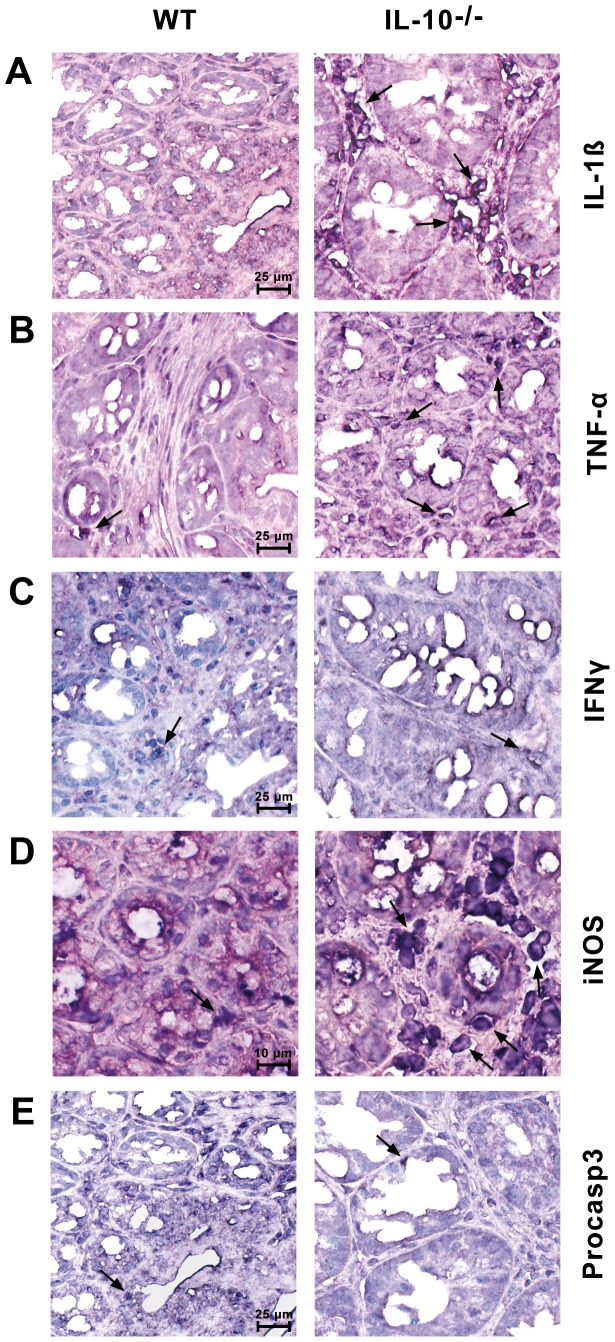
Gene expression by in situ RT-PCR of proinflammatory cytokines, iNOS, and procaspase 3 in the colonic mucosa.(A) and (B) High expression levels of IL-1β and TNF-α in infiltrating immune cells of IL-10−/− mice. (C) IFN-γ exhibited scant expression in only single immune cells of IL-10−/− mice and healthy WT mice. (D) High expression of iNOS in the immune cells surrounding the epithelial cells and in single immune cells in the connective tissue of the mucosa compared to WT mice. (E) Comparable procaspase 3 expression in WT and IL-10−/− mice. Arrows show representative mononuclear cells. Representative images of three independent experiments.